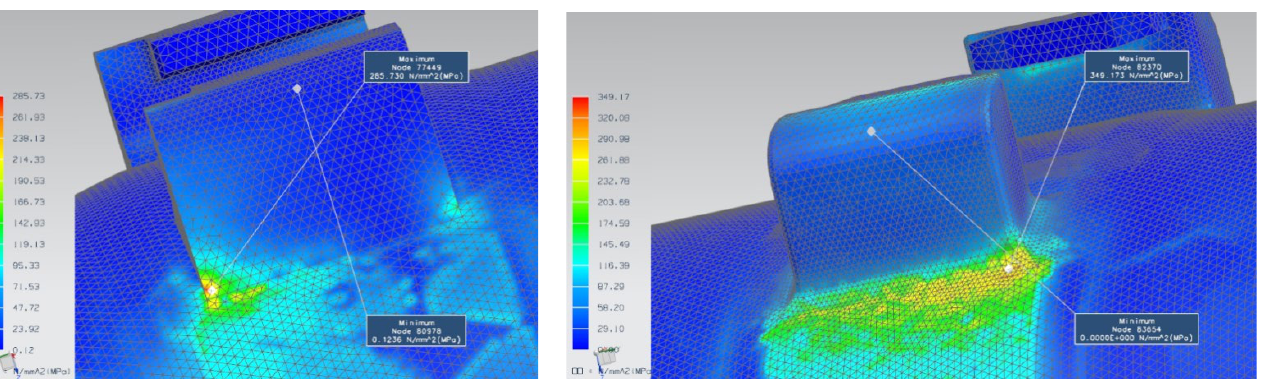
Figure 4. Vibration spectrum. After the vibration test, the structure was sampled transversely and longitudinally. The metallographic morphology images are presented in Figure 5 at a magnification of 200. Typical morphology of cracks, such as stripes, was not observed. Hence, it was as- sumed that the structure can effectively cope with the stress load during hanging flight. Figure 5. Metallographic morphology of the transverse and longitudinal structure of the “T”-shaped structure.